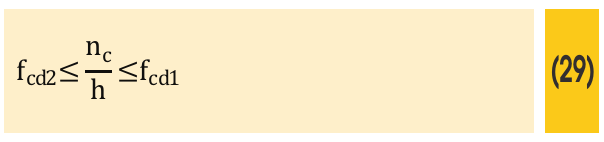
Figure 3 – Stress-strain diagram